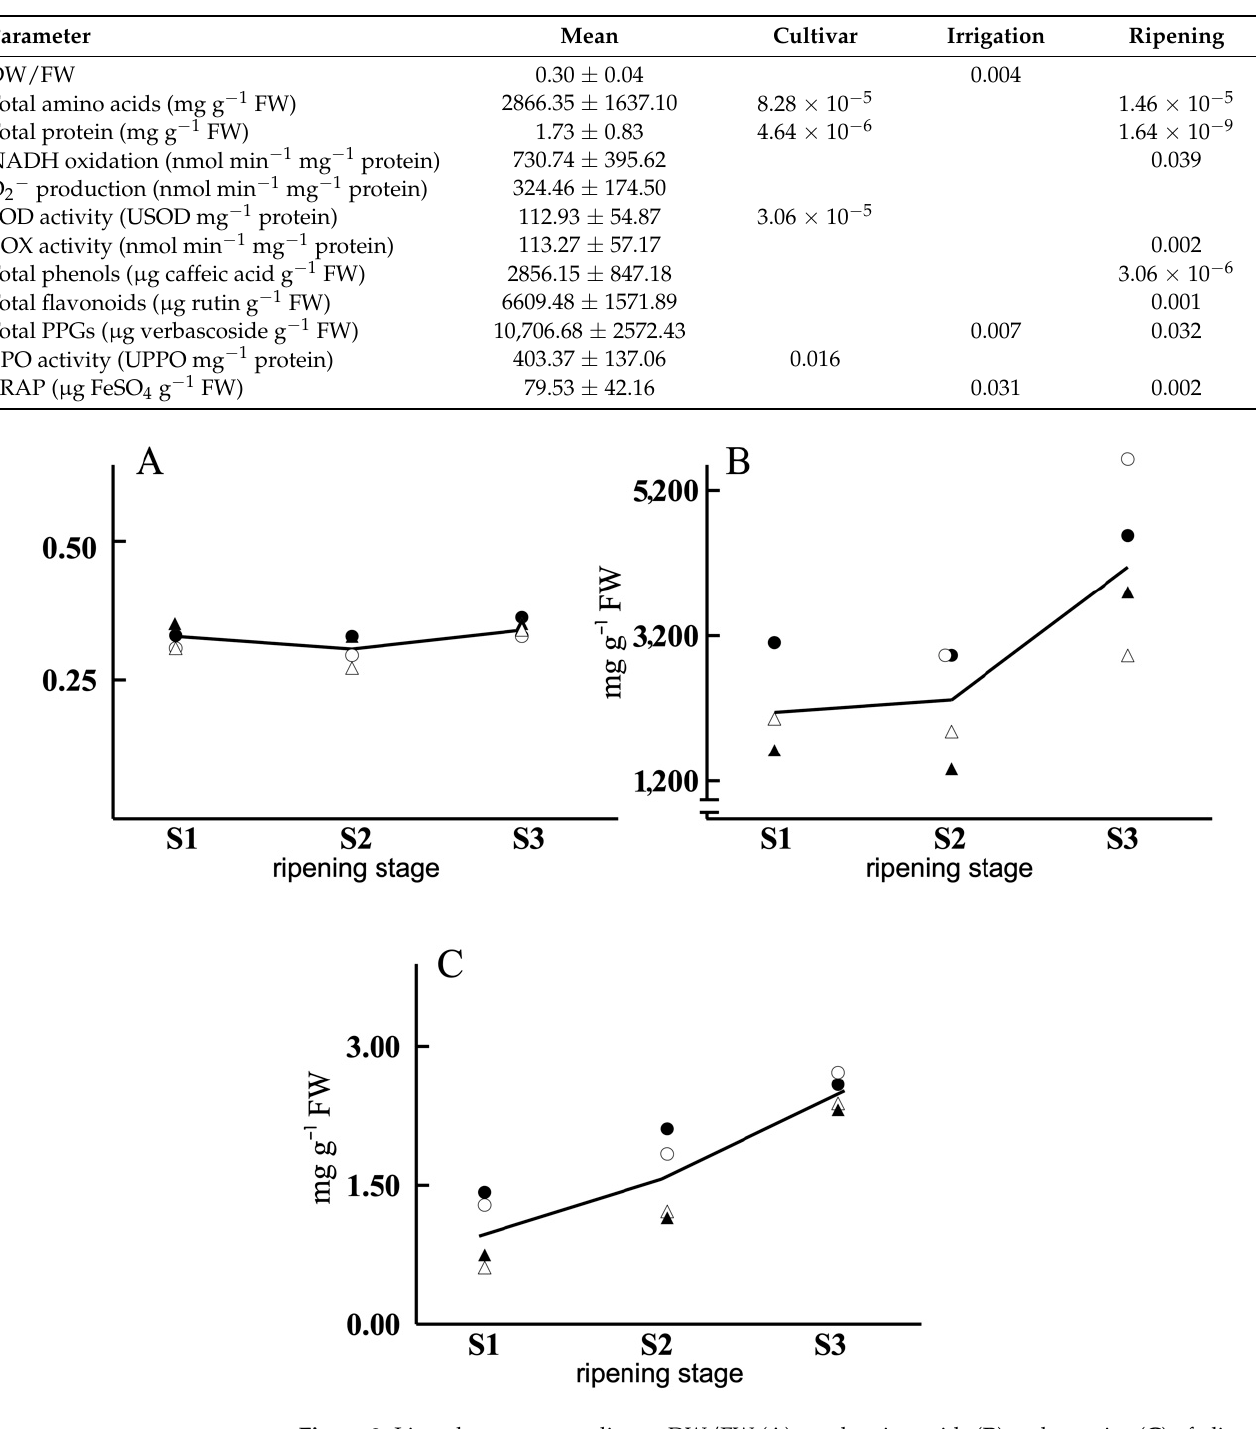
Table 1. Mean values of the content parameters and estimates ( p -values) of the influencing factors (derived from Table S3).